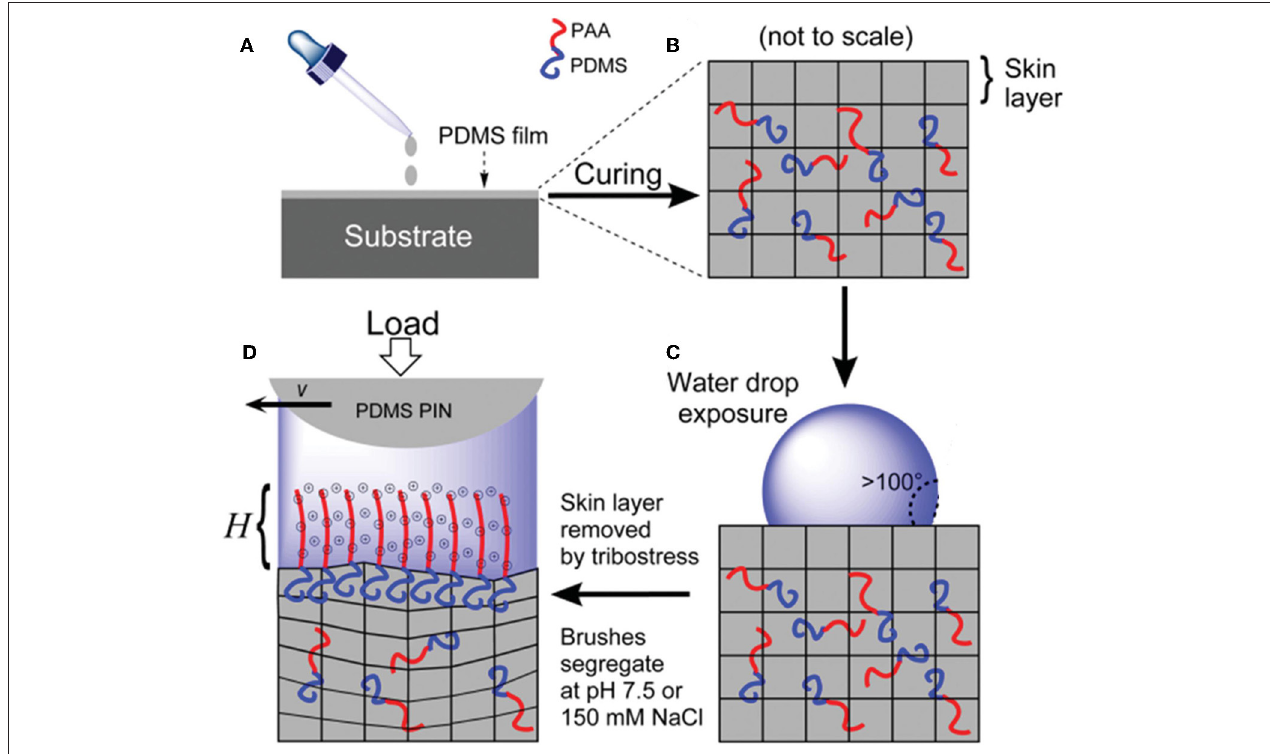
FIGURE 3 | (A) Coating of a substrate with a PDMS film. (B) Crosslinked PDMS matrix incorporating diblock copolymers and a skin layer. (C) High water contact angle is attributed to the PDMS skin layer formation. (D) Tribostress shears off the skin layer and induces brush segregation with charges and counter ions. H is